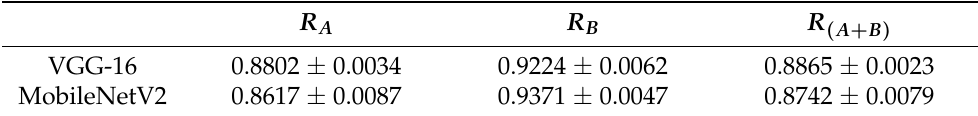
Table 7. Cumulative strategy results. Results averaged over 5 iterations ( ±